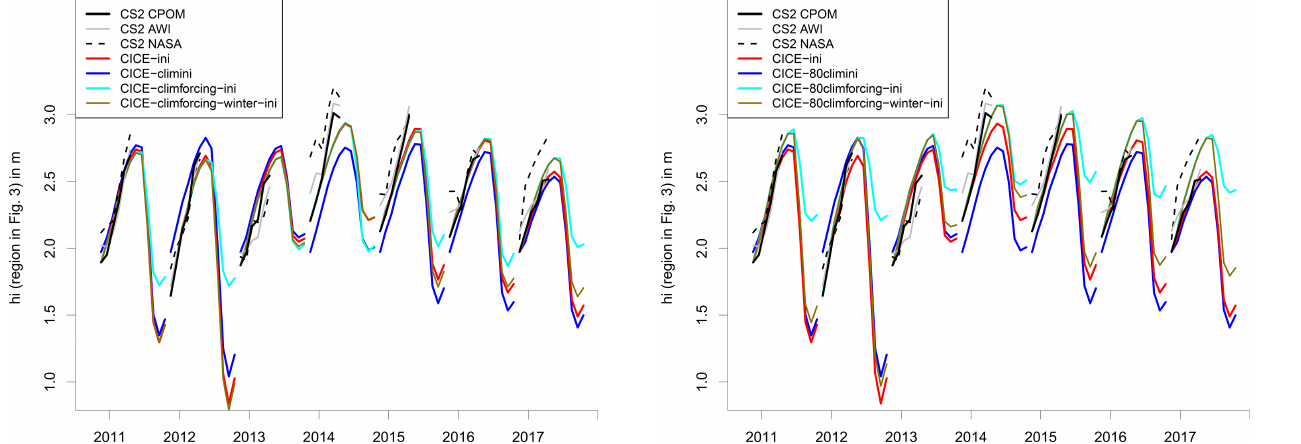
Figure 11. As Fig. 10, but applying a climatology calculated over the period 1981 to